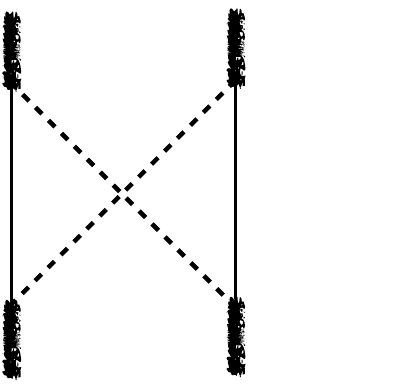
Figure 2 . On the left, conformal diagram of the maximal extension of the sub-extremal black brane. At each point we have ommited the transverse R d factor. The solid lines represent the two conformal boundaries where each of the CFT copies in the thermo(cid:12)eld double state (2.14) live. Dashed lines represent black brane (outer and inner) horizons. Beyond the inner horizon lie timelike singularities, represented by fuzzy lines. When the black brane becomes extremal, the outer and inner horizons coincide; the left and right pieces disconnect, and the resulting conformal diagram is depicted on the